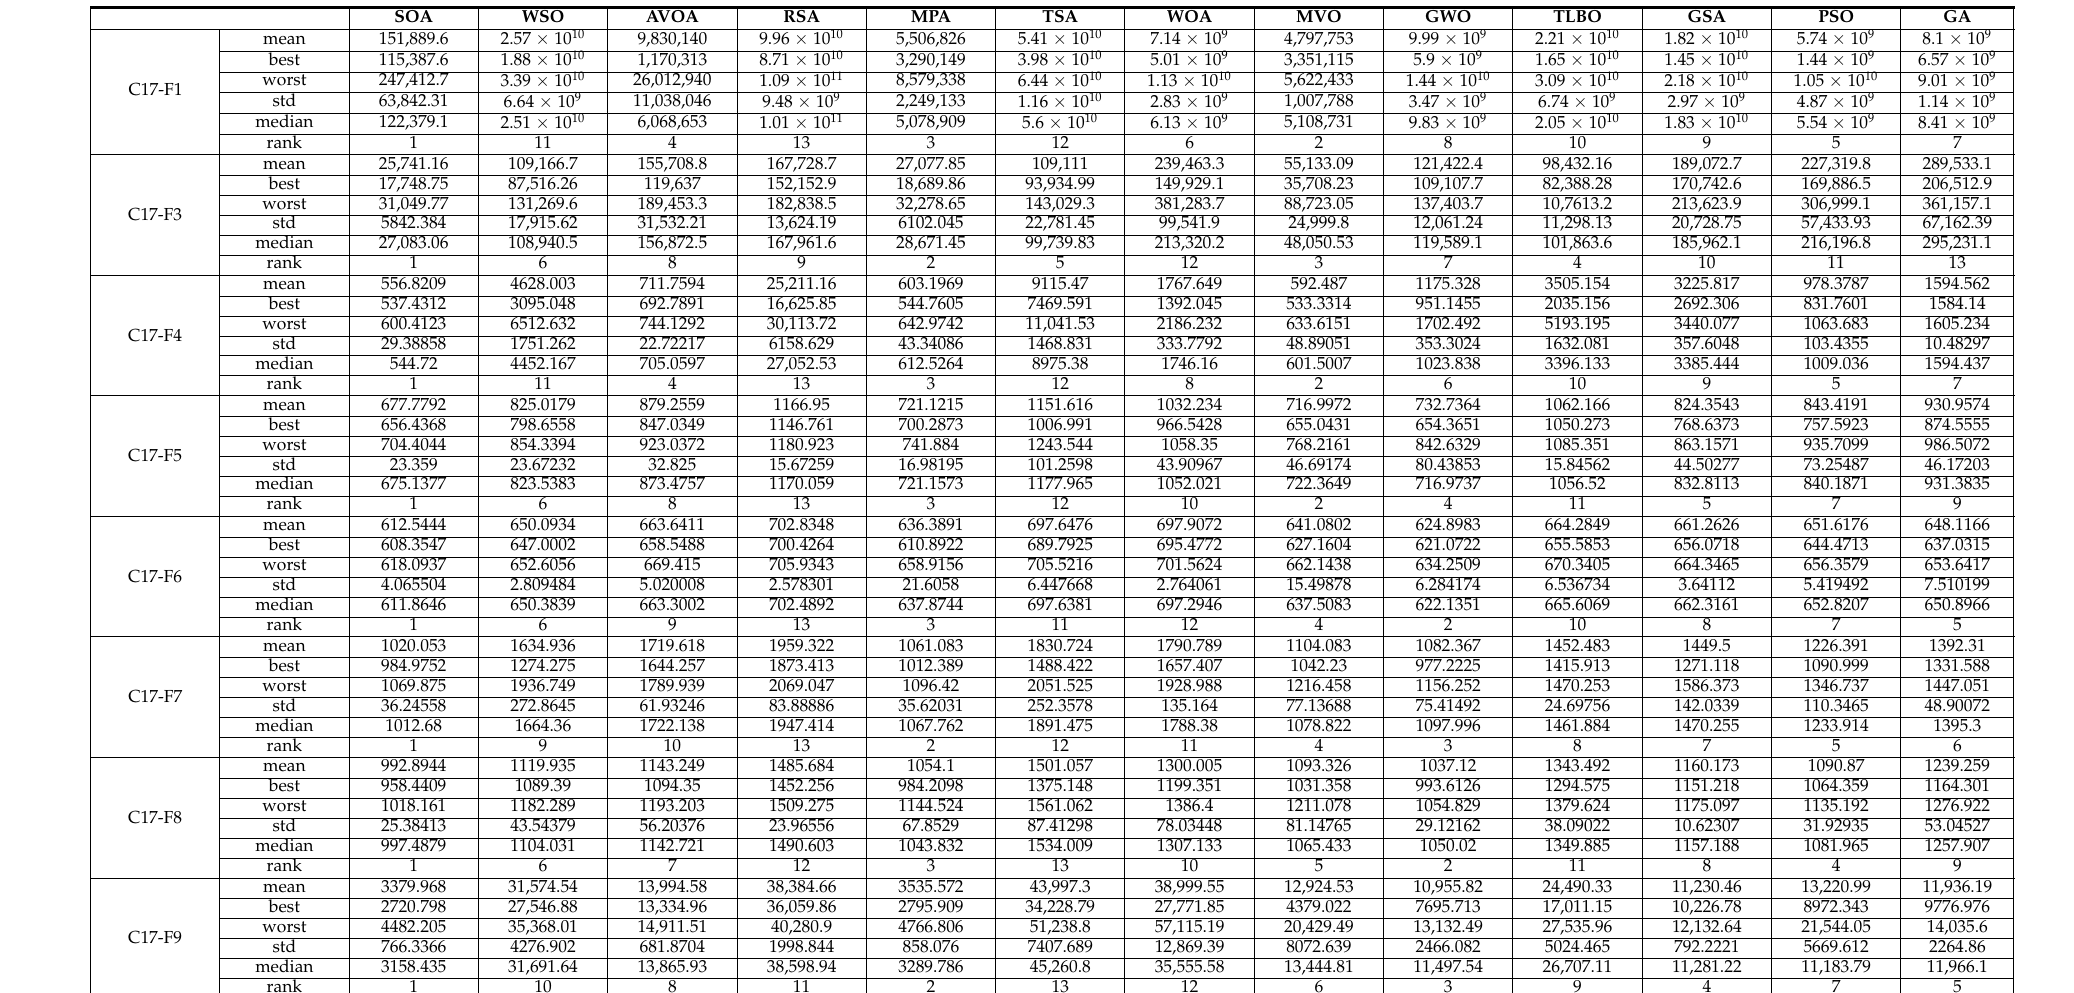
Table 4. Optimization results of the CEC 2017 test suite (for the dimension d =